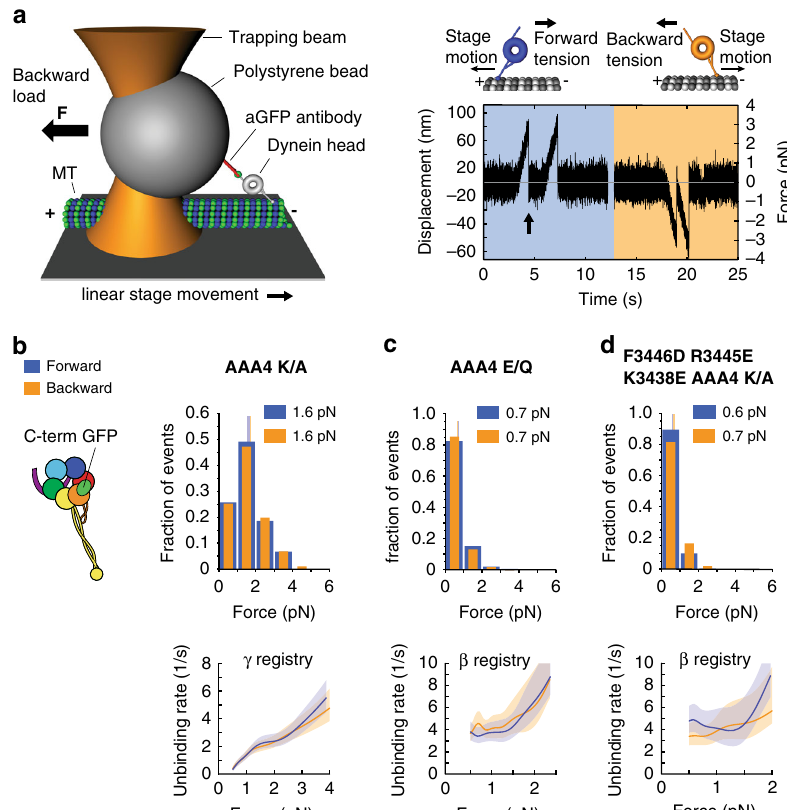
Fig. 3 AAA4-ATP binding controls the linker undocking and the transition from the γ registry to the β registry. a (Left) A polystyrene bead bearing a dynein motor is held in an optical trap as the microscope stage sweeps back and forth parallel to a MT (not to scale). (Right) Position (force) vs. time for the AAA4 K/A Dyn1 331kDa -GFP mutant in the presence of 1 mM ATP. Orange and blue shaded areas show periods of applied backward and forward tension, respectively (loading rate: 5.6 pN/s; k = 0.036 pN/nm, v stage = 156 nm/s). After the motor binds the MT, it pulls the bead out of the trap. Force on the motor increases until the dynein-MT bond ruptures at the “ unbinding force ” (arrow), here ∼ 3 pN. b (Left) Schematic of dynein with GFP fused to the C-terminus. (Right) Normalized histograms of primary forward and backward unbinding forces of the AAA4 K/A Dyn1 331kDa -GFP mutant in the presence of 1 mM ATP. The mean values are noted. Tall vertical bands represent 95% CIs of the means (forward: [1.5, 1.7] pN, backward: [1.5, 1.7] pN), which were estimated by bootstrapping 4000 samples. (Bottom) Unbinding rate vs. force derived from the data above. The shaded areas are 95% CIs for the mean rates, which were also estimated by bootstrapping. c Same as b , but for the AAA4 E/Q mutant (95% CIs [0.64, 0.70] and [0.64, 0.71] pN). d Same as in b , but for the F3446D R3445E K3438E AAA4 K/A-Dyn1 331kDa -GFP mutant (95% CIs [0.63, 0.7] and [0.65, 0.72] pN). The number of events in the forward and backward directions: ( b ) (269, 278), ( c ) (409, 429), and ( d ) (236, 151). Source data are provided as a Source Data fi